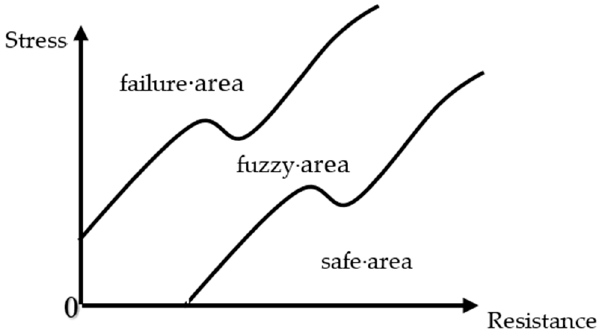
Figure 7. Fuzzy damage state of the structure.